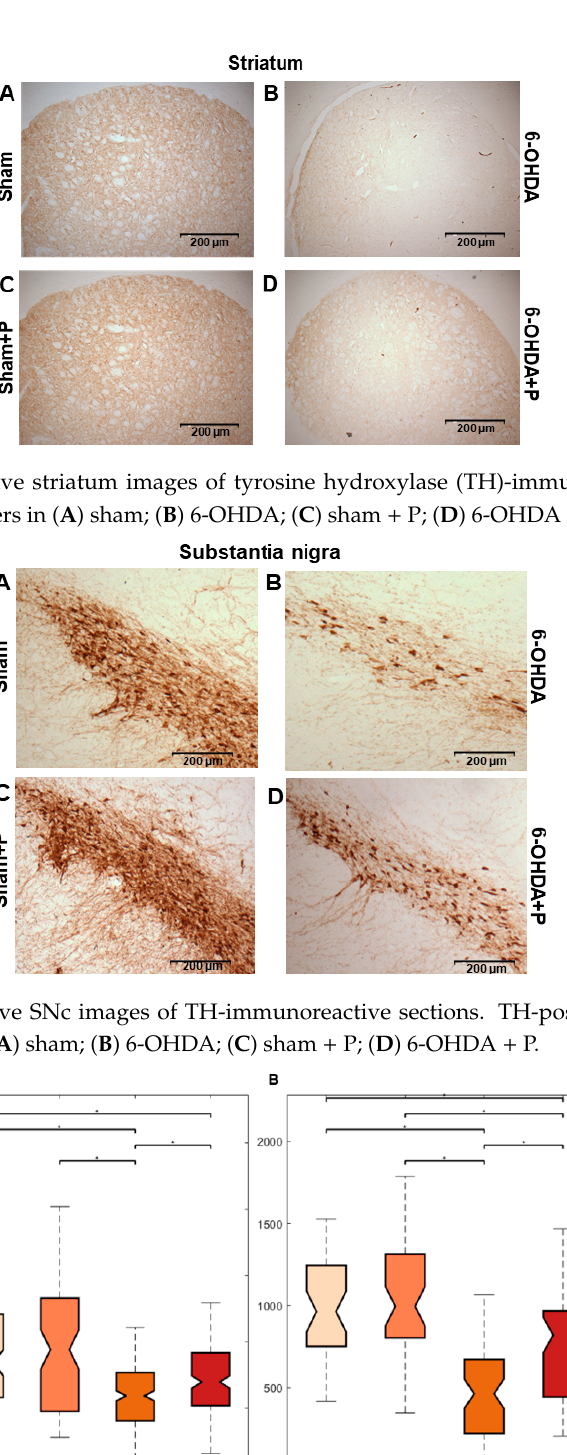
8 of 18 Figure 6. Histograms showing distribution of R-R intervals by length range. ( A ) sham: RR interval from 0.12 to 0.206 s; ( B ) 6-OHDA: RR interval from 0.175 to 0.237 s; ( C ) sham+P: RR interval from 0.095 to 0.212 s; ( D ) 6-OHDA+P: interval RR of 0.15 to 0.212 s. 3.2. Tyrosine Hydroxylase Immunohistochemistry The immunohistochemistry procedure was performed on 17 animals (groups: sham, n = 3; sham+P, n = 4; 6-OHDA, n = 5; 6-OHDA+P, n = 5). TH-positive immunoreactivity was applied as a marker of viable dopaminergic neurons in the SNc and dopamine fibers in the striatum (Figures 7 and 8). In the striatum, an optical density analysis was carried out, and it showed that all groups were significantly different from the 6-OHDA group (chi-square = 22.51, p = 5.11 × 10 − 5 ) (Figure 9A). In the SNc region, by counting dopaminergic neuronal nuclei, significant differences were detected in all groups when compared to both 6-OHDA group and 6-OHDA+P group (chi-square = 45.72, p = 6.5016 × 10 − 10 ) (Figure 9B). Nevertheless, 6-OHDA-injured rats exhibited less TH-stained striatal fibers and less TH-positive neural nuclei in the SNc than the 6-OHDA-lesioned rats treated with propolis, suggesting a protective effect of propolis against 6-OHDA-induced neurodegeneration of the